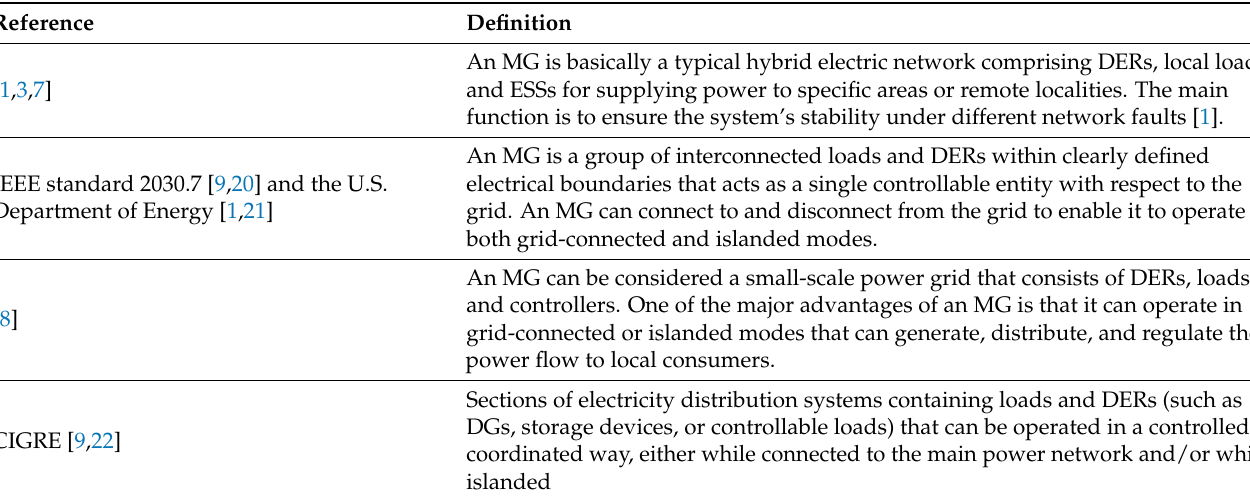
Table 3. Main characteristics of different types of MGs. Table 2. Different definitions presented for an MG.